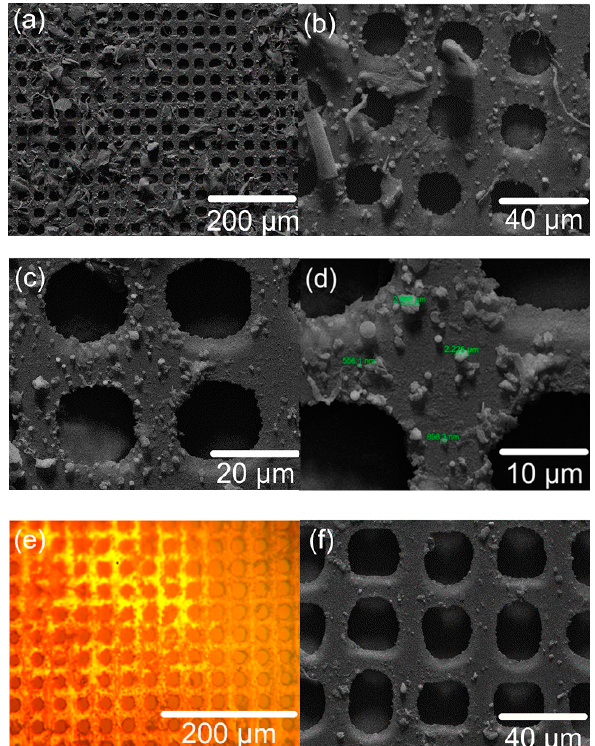
Figure 2. SEM images of a Kapton filter operated for 7 days. Micro dust is captured at the surface and around the pores. The magnifications are ( a ) 200×, ( b ) 900×, ( c ) 1500×, and ( d ) 2900×. Representative dimensions of the PM are shown in ( d ). ( e ) Optical microscope and ( f ) SEM images of a Kapton filter washed with tap water after filtration.